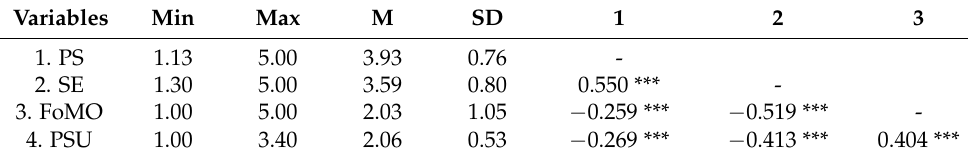
Table 2. Descriptive statistics and correlations between main